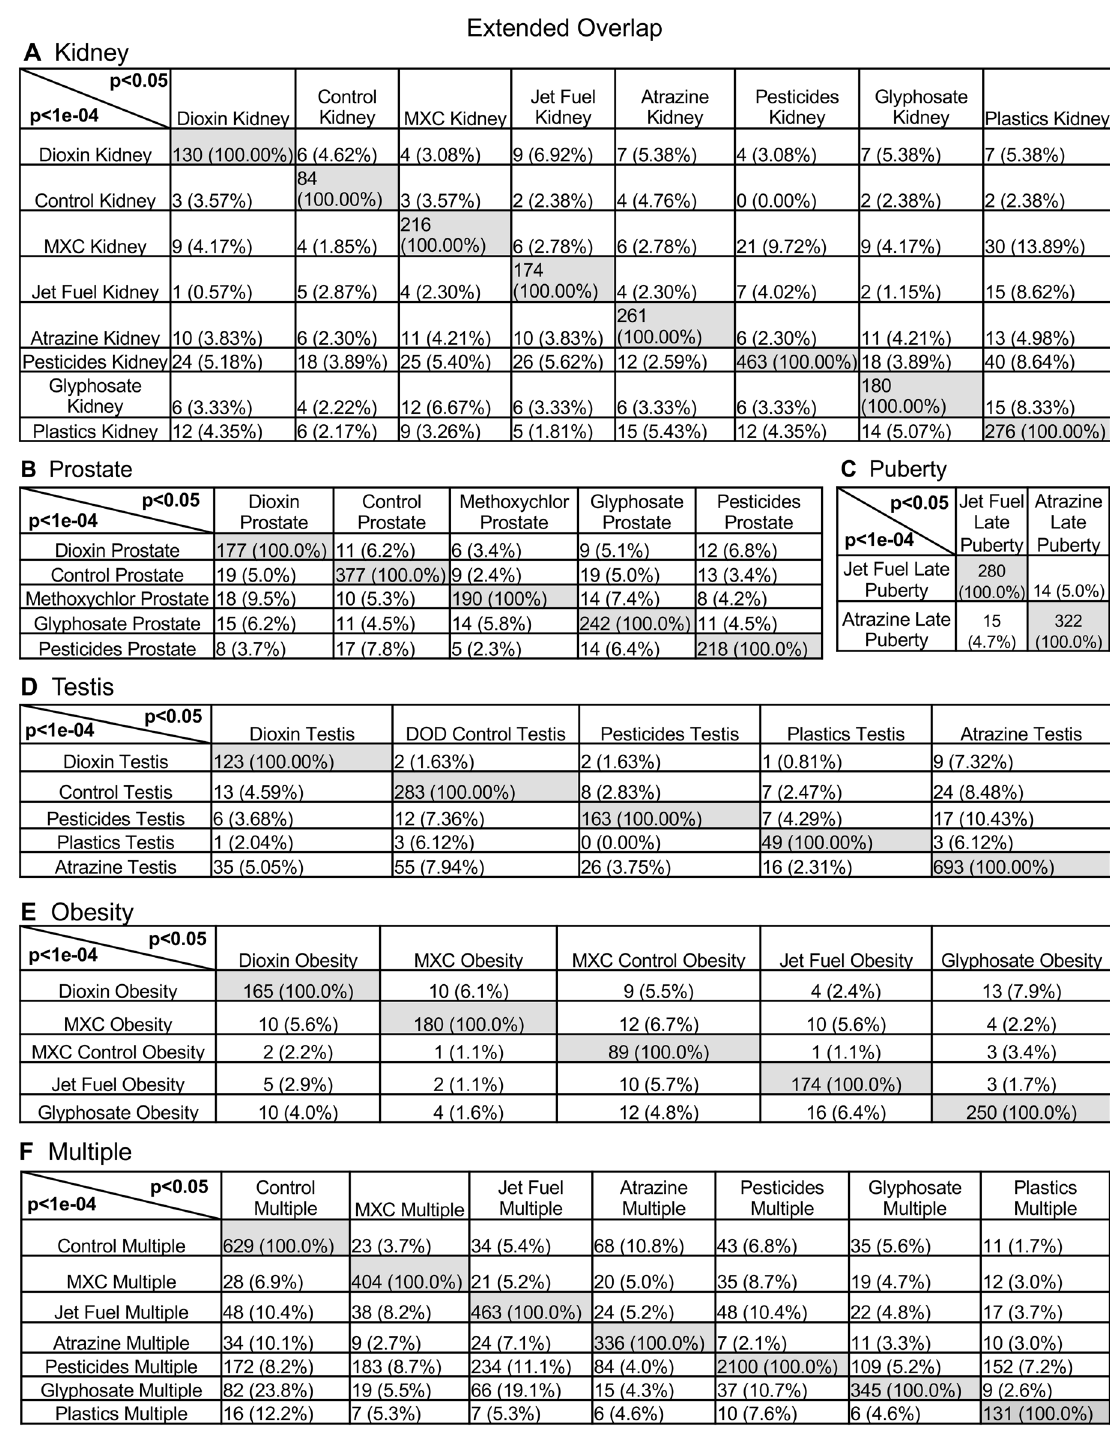
Figure 3. Extended disease specific DMR overlap at p < 1e−04 versus p < 0.05. ( A ) Kidney; ( B ) Prostate; ( C ) Puberty; ( D ) Testis; ( E ) Obesity; ( F ) Multiple. The DMR number and percentage overlap presented. The horizontal row overlap identifies DMR number and percentage for each